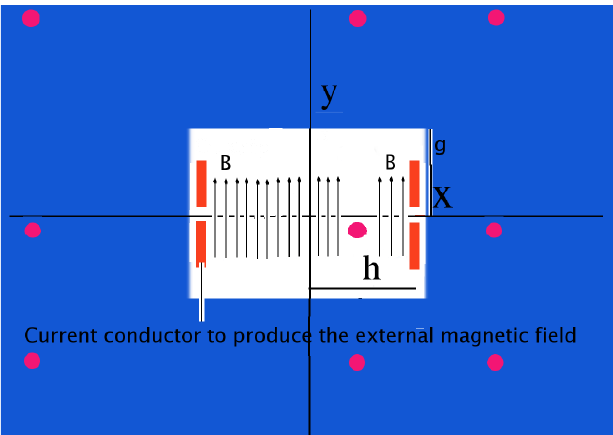
FIG. 6. (Color) The schematic picture of the i th Cu coil, which FIG. 5. (Color) The effect of the ferromagnetic yoke, which is is denoted by the red line. The brown objects denote capacitors. denoted by the blue object, is replaced by that of the image The coil is originally defined by combining the i th and (cid:1) i th Cu currents that are represented by pink objects. The image currents stripes and the flanges on both sides of the chamber as shown in ; 2 ng (cid:1) ð(cid:1) 1 Þ n a cos (cid:2) ; z (cid:4) , are located at ½ 2 mh þ ð(cid:1) 1 Þ m a sin (cid:2) the left figure. As a result of applying Gauss’s law in one of i i where m and n are arbitrary integers. The orange objects denote Maxwell equations ( div B ¼ 0 ), the form of this coil can be the current conductors to produce the external magnetic field deformed to that in the right figure, because the longitudinal B ð t Þ . component of magnetic field is assumed to be